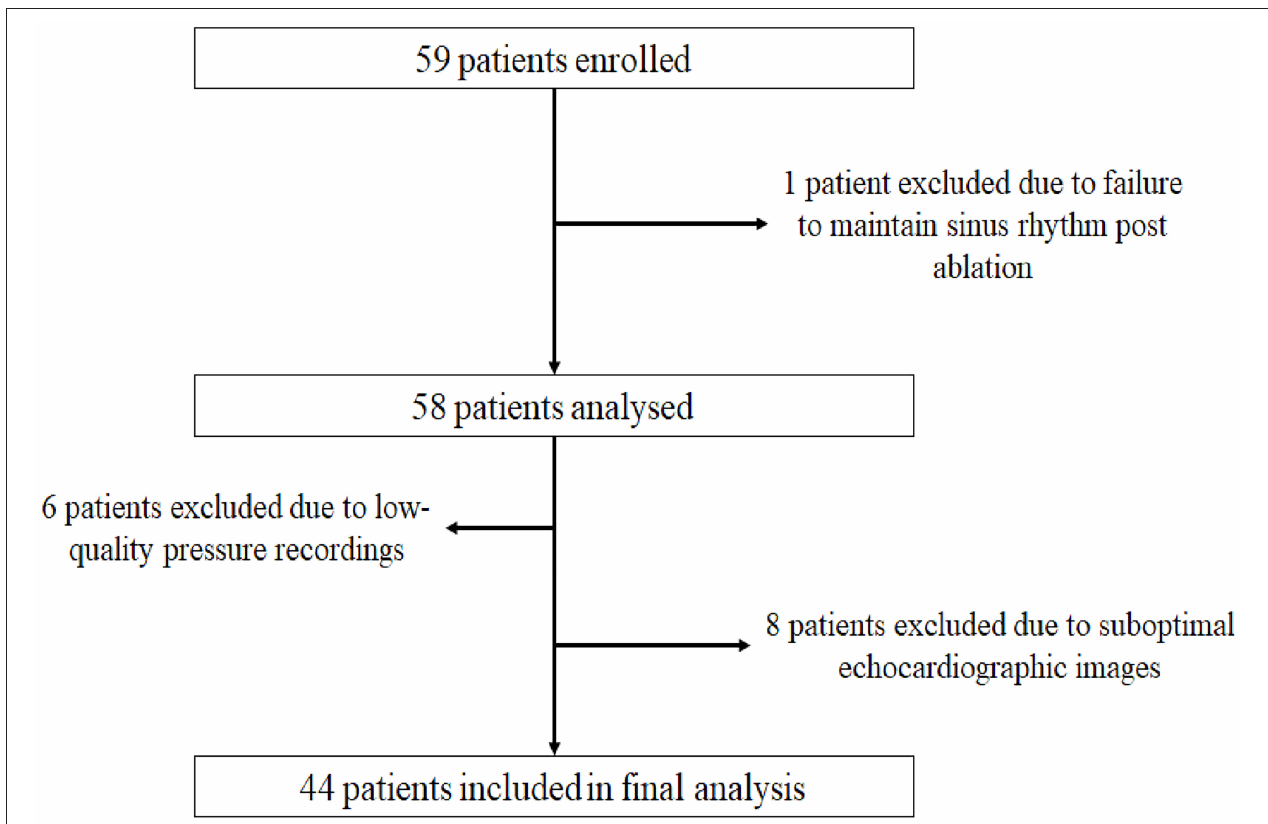
FIGURE 2 | Study flow